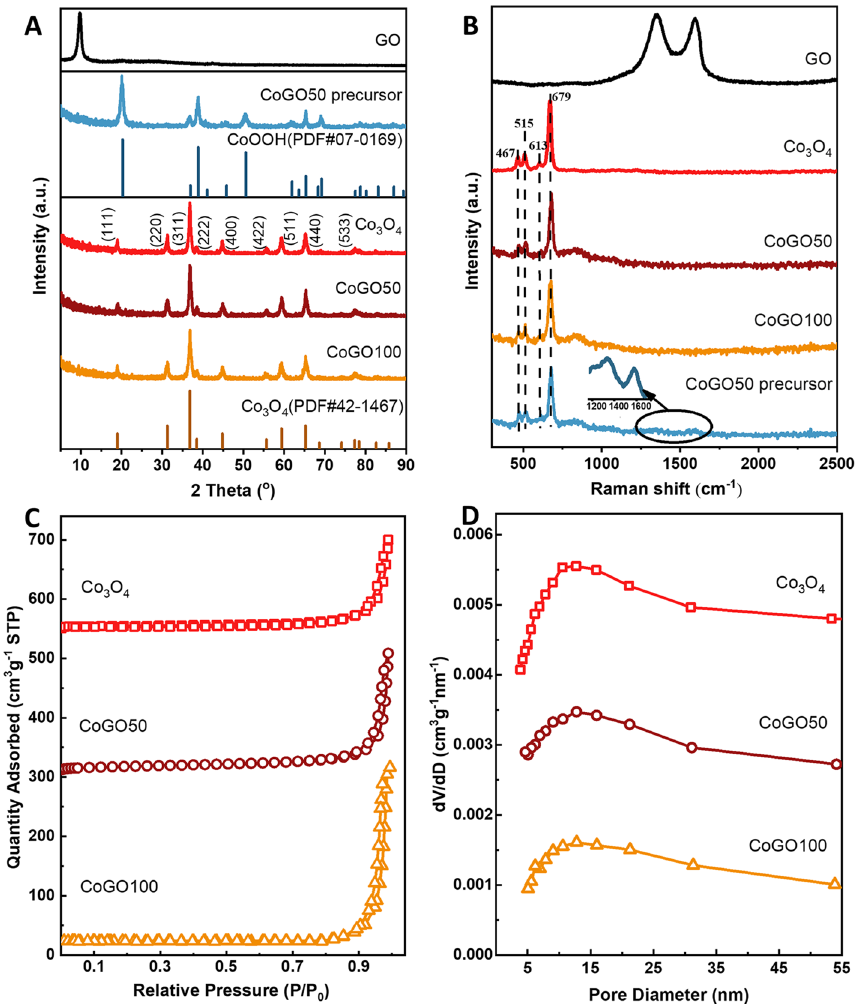
Figure 2. ( A ) XRD patterns and ( B ) Raman spectra of GO, Co 3 O 4 , CoGO50 and CoGO100; ( C ) Nitrogen adsorption–desorption isotherms and ( D ) the pore distribution of Co 3 O 4 , CoGO50 and CoGO100.